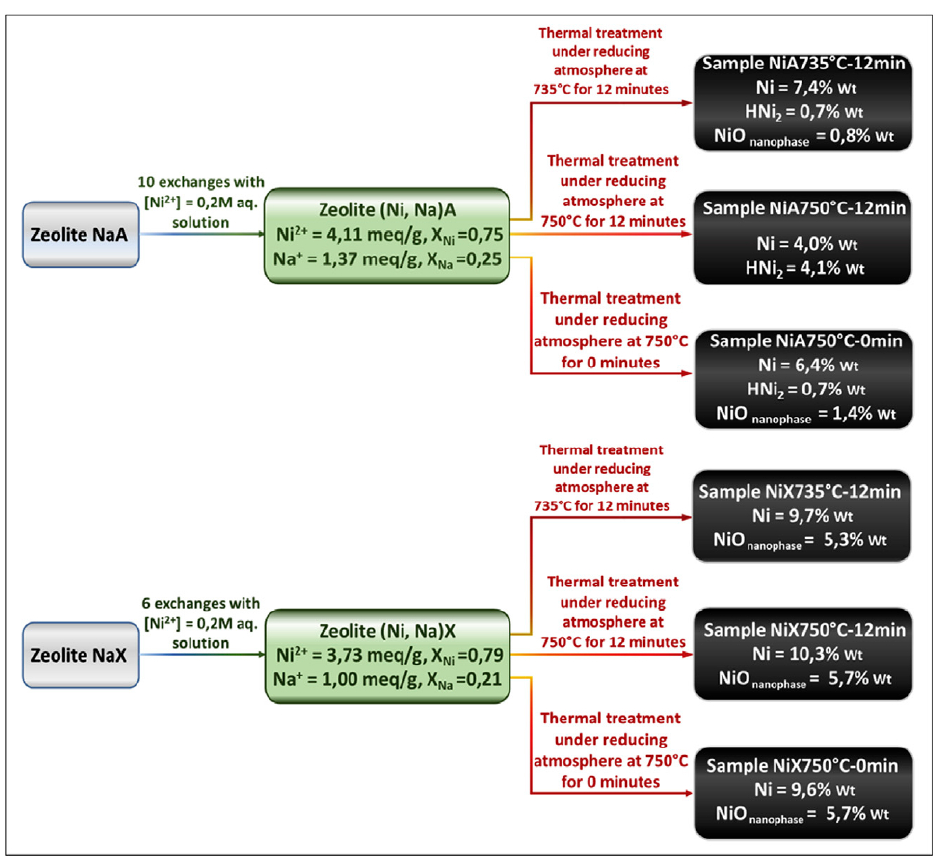
Figure 10. Sequence of the operations implemented in the preparation of Ni NCs. Reprinted from the work of [64] with permission from Elsevier.